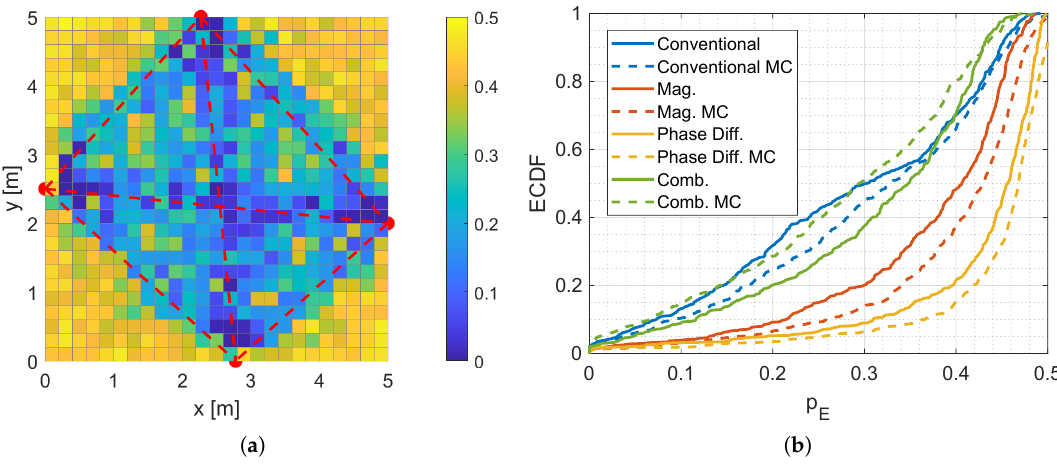
Figure 11. Simulation results for the different DFL systems. ( a ) Simulation of the conventional DFL system. The color coding represents p E . ( b ) Comparison of the position error probabilities of the simulated